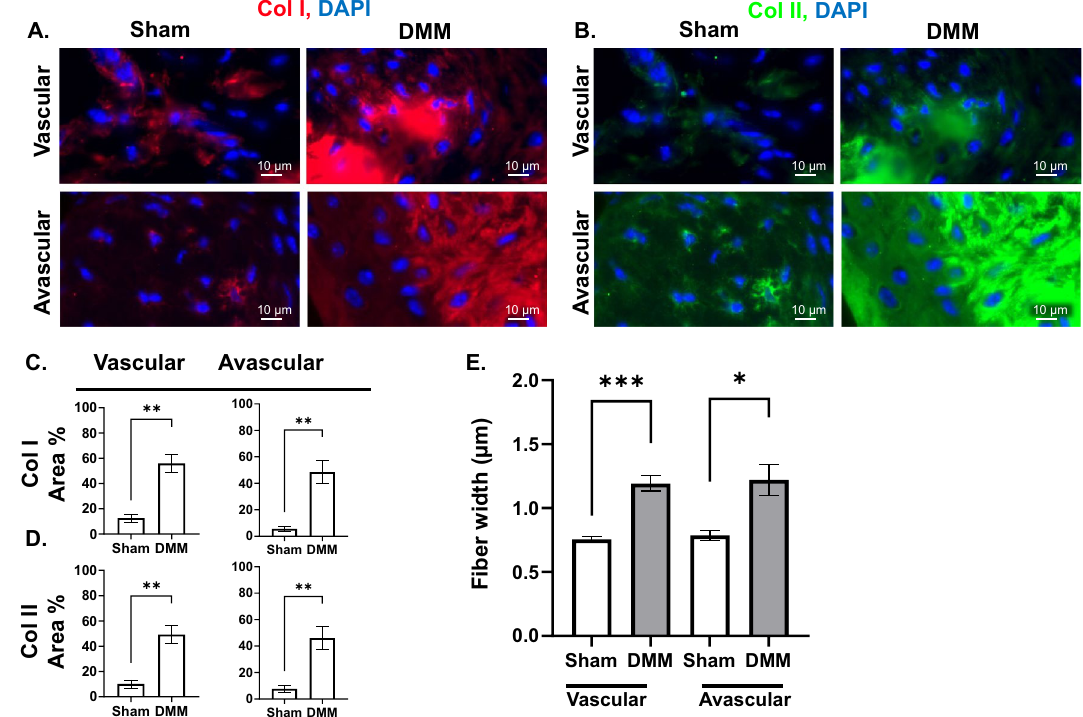
Figure 5. OA results in changes to collagen composition and fiber thickness in the anterior meniscus. IF staining for ( A ) Col I and ( B ) Col II expression in vascular (peripheral) and avascular (internal) regions of the anterior meniscus (× 40 magnification, scale bar = 10 μm, images acquired with Zeiss Zen Blue 2.6 edition software). Quantification of area percentage (area of positive signal normalized to total selected area) of ( C ) Col I and ( D ) Col II IF stains. ( E ) Comparison of FSHG fiber width (μm) between sham and DMM samples in each ROI. * P < 0.05, ** P < 0.01, *** P < 0.001 using unpaired t-test with Welch’s correction, values are expressed as mean ± SEM; 3 images were analyzed per ROI in each sample, N =